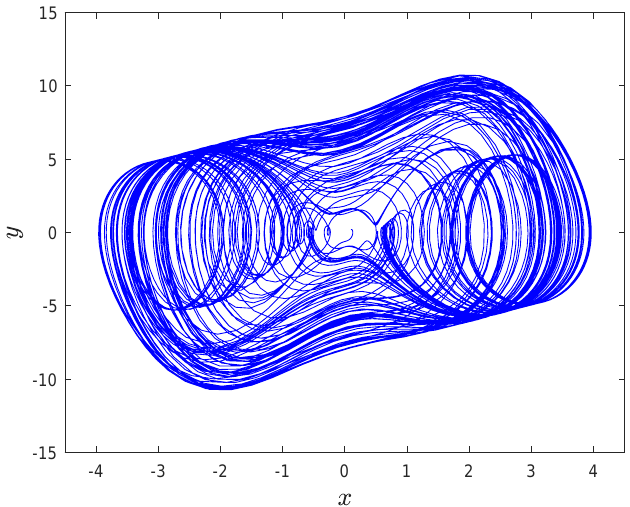
Figure 2. The attractor of dynamic system (6) with initial values ( x 0 , y 0 ) = ( 0.1,0.2 ) .